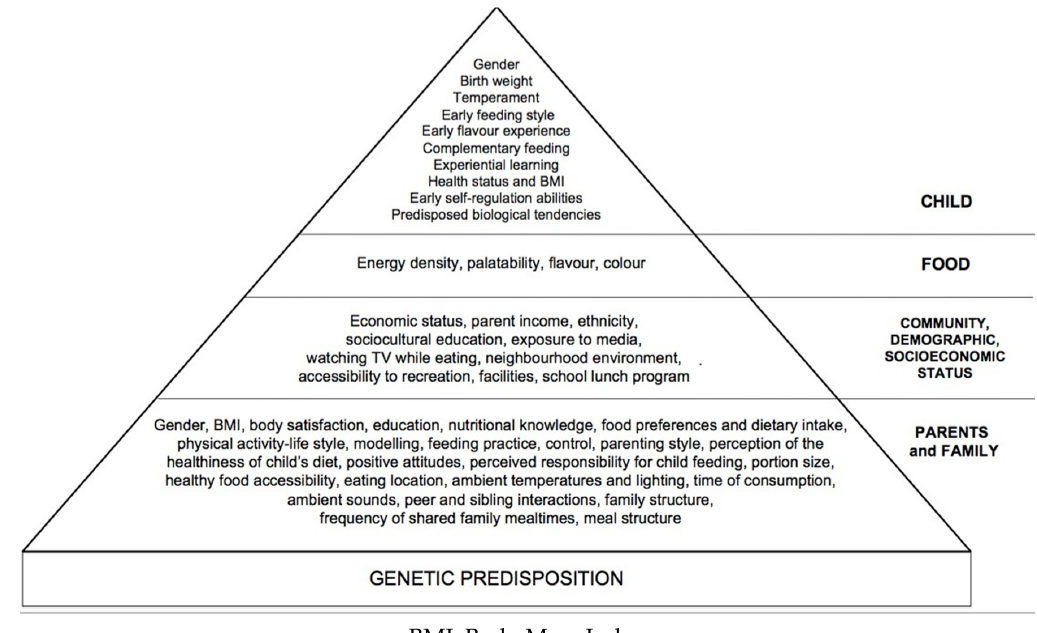
Figure 1. Environmental factors that influence child eating behavior.